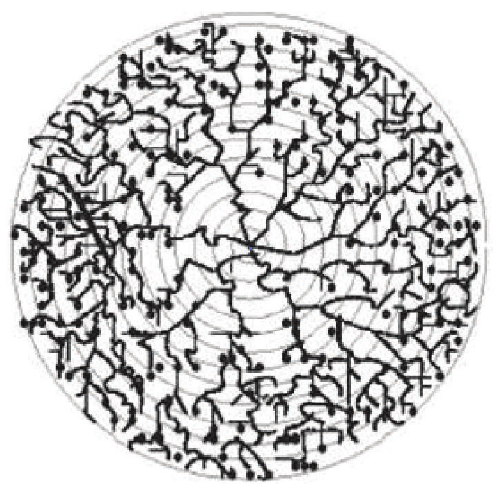
Figure 2: The scheme of percolation fractal cluster of solid-like filaments.